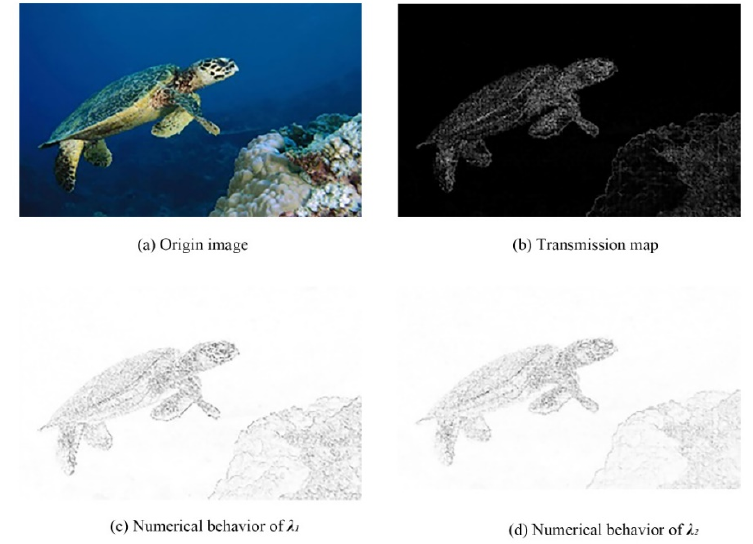
Figure 3. Numerical behavior of λ 1 and λ 2 .